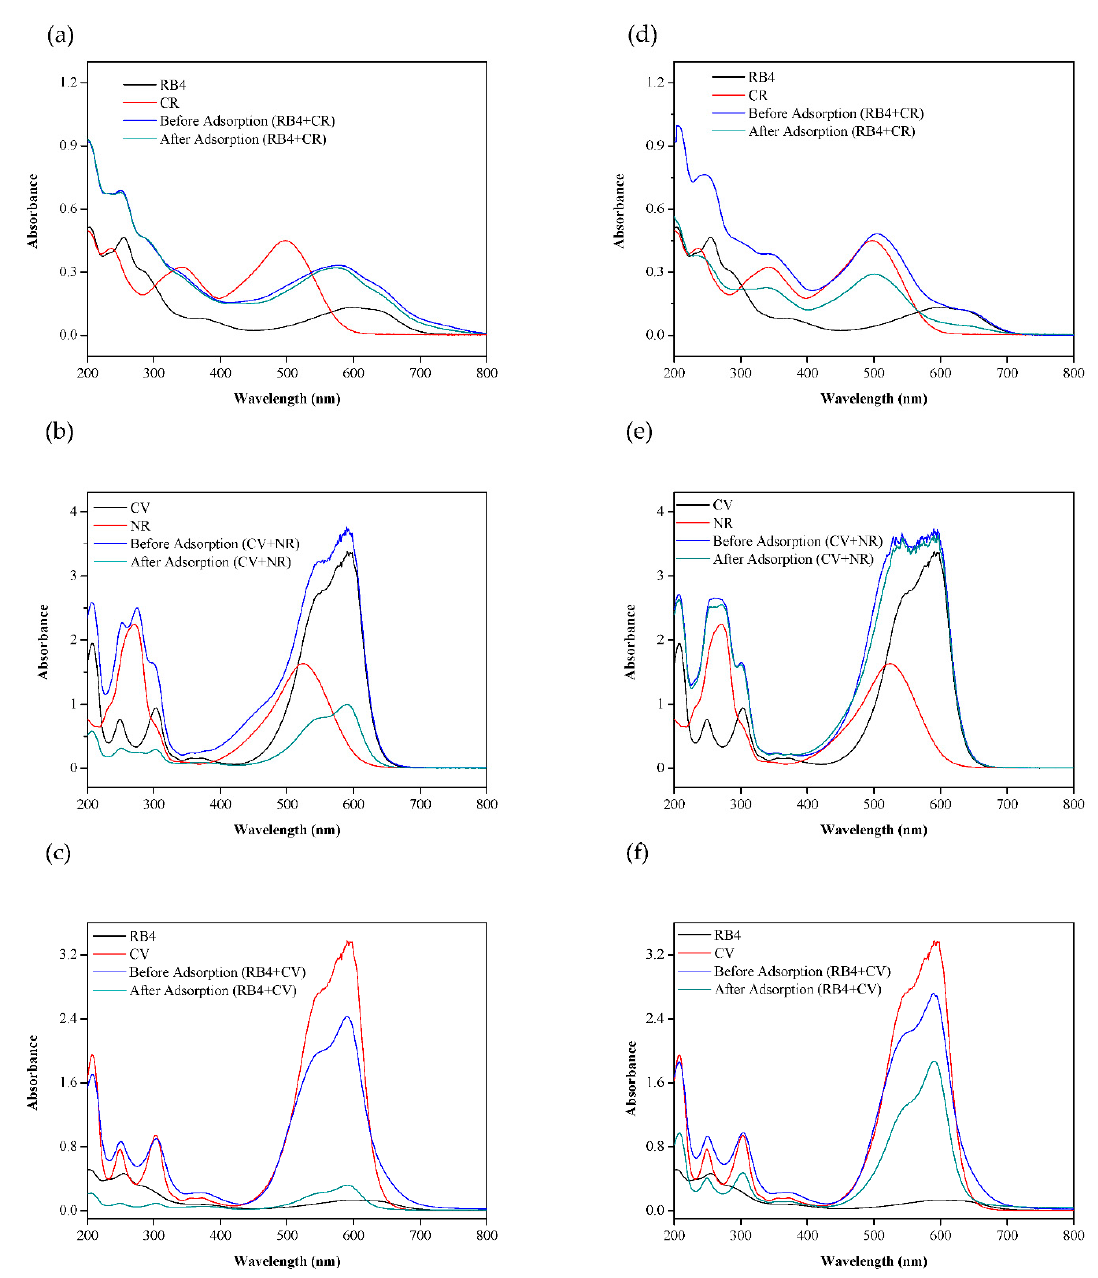
Figure 10. The absorption spectra of the dye mixture onto MHAF-SA ( a–c ) and MHAF-CS ( d–f